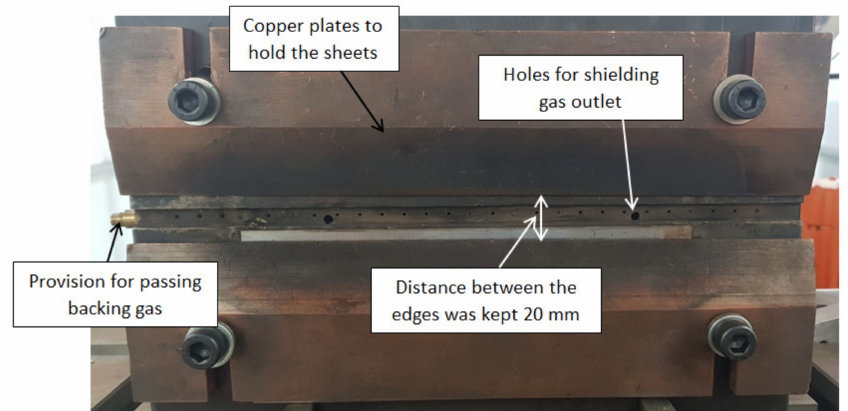
Figure 1. Fixture designed for holding the sheets in position during welding.